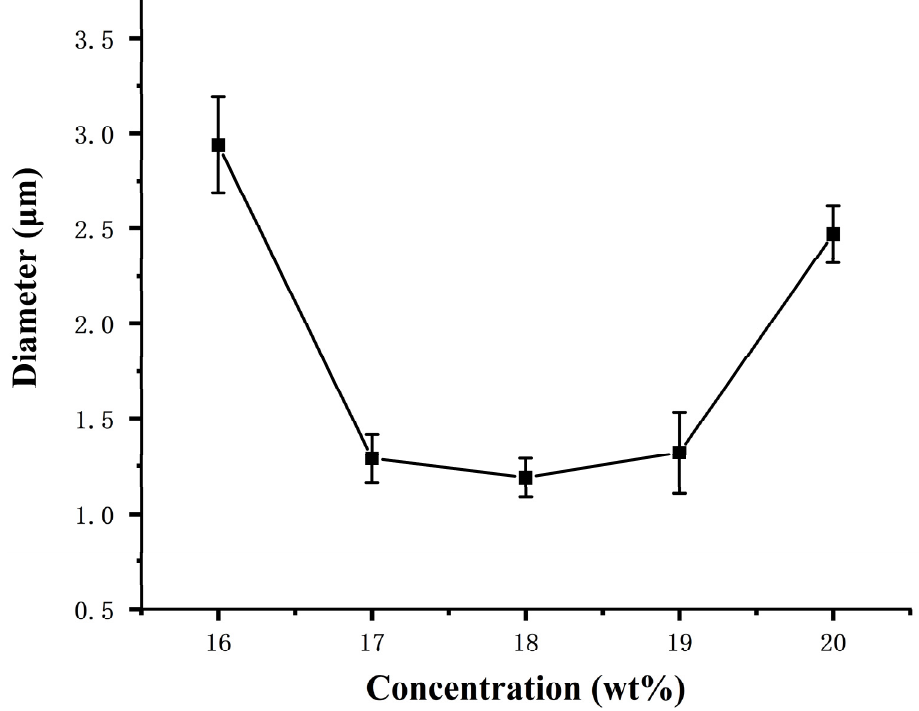
Figure 3. Variation curve of CA fiber diameters with spinning concentration solution.